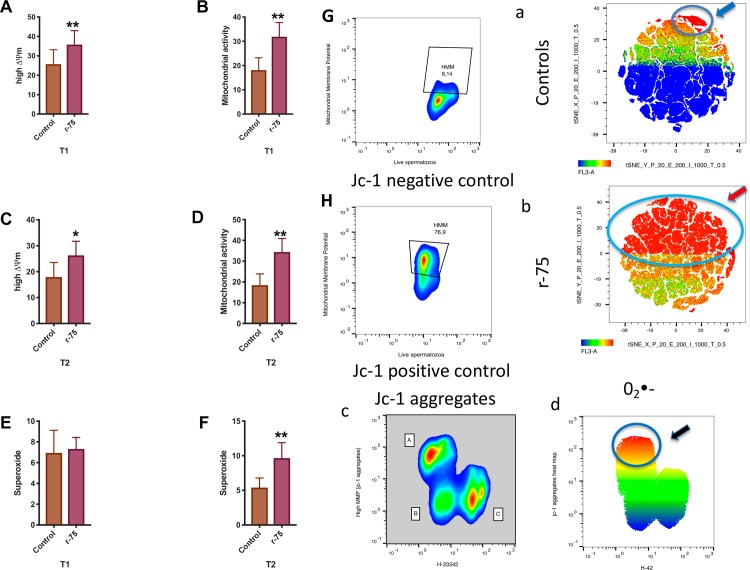
Effects of rosiglitazone added to the thawing media on mitochondrial function of stallion spermatozoa after thawing.Frozen stallion semen was thawed and processed as described in the Materials and Methods. Split samples were supplemented with rosiglitazone (0 and 75 μM) and mitochondrial functionality was investigated after 1 and 2 hours of incubation. A and C, percentage of spermatozoa showing orange fluorescence after JC-1 staining, B and D, mitochondrial functionality expressed as the mean fluorescence intensity in the PE channel indicative of JC-1 aggregates (high mitochondrial potential), E and F production of superoxide after 1 and 2 hours of incubation at 37°C. The results are presented as the means ± SEM. * P<0.05, ** P<0.01. In a and b, the t-SNE map after computational analysis is shown; in the t-SNE map, each point represents individual spermatozoa in the sample, and the heat map applied to the t-SNE map shows increased PE fluorescence (jc-1 aggregates) in the rosiglitazone treated samples. Circles identify the populations of spermatozoa showing high ΔΨm. In c a representative 2D plot after JC-1/H33342 is presented, A live spermatozoa with high ΔΨm, B live spermatozoa, C dead spermatozoa. In d the same plot is presented but a heat map overlay of the APC channel (production of superoxide) is shown over the 2D plot depicted in c, maximum production of superoxide is present in live sperm showing high ΔΨm (orange events in the plot), and this population is also circled (black arrow). Controls for the JC-1 are presented; G negative controls that are samples treated with the mitochondrial uncoupler CCCP 5 μM. Positive controls are presented in H; they are samples treated with oligomycin 10 μM to inhibit the passage of H+ to the mitochondrial matrix (results are derived from three independent frozen ejaculates from 6 different stallions n = 18).